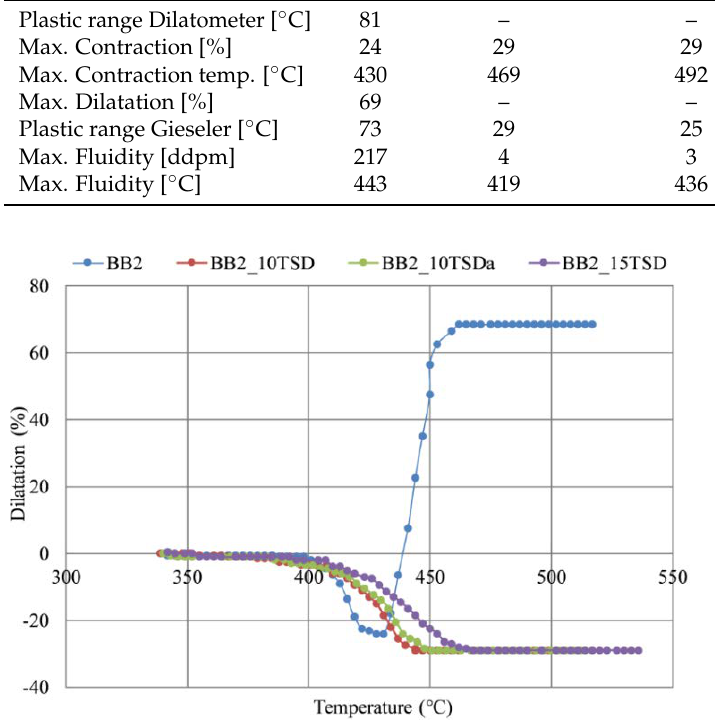
Figure 3. Dilatation for the blends carbonized in technical scale, average of two tests.